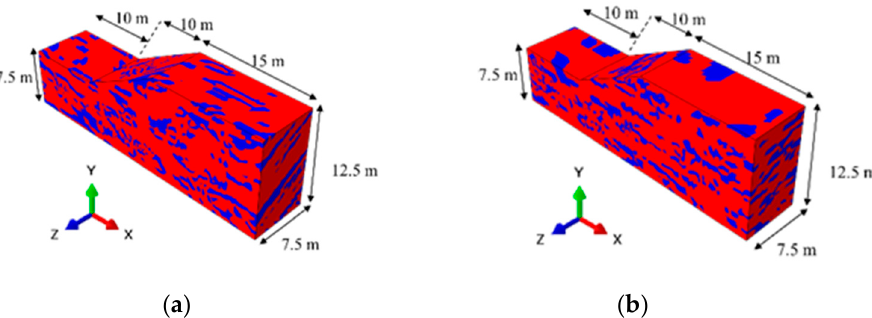
Figure 6. Schematic diagram of the distribution of weak zones with different inclination angles. ( a ) Rotation angle of 30° around the X -axis; ( b ) rotation angle of 0.